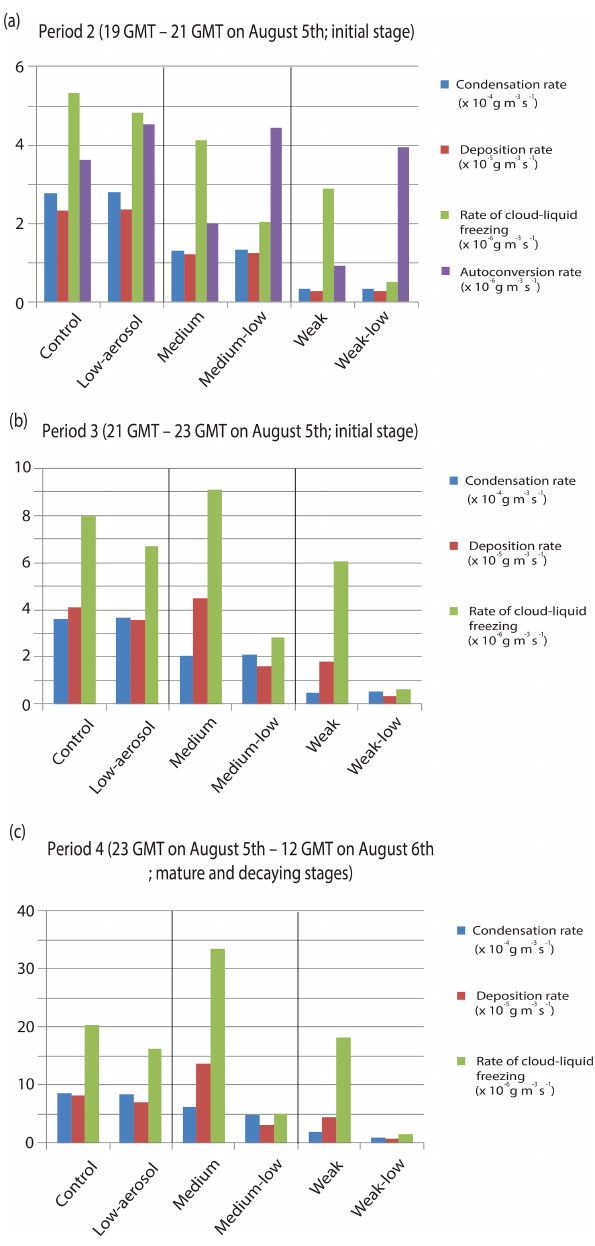
Figure 9. Average rates of condensation, deposition and cloud- liquid freezing at all altitudes in cloudy areas and over periods (a) 2, (b) 3 and (c) 4. In panel (a) , average autoconversion rates are also